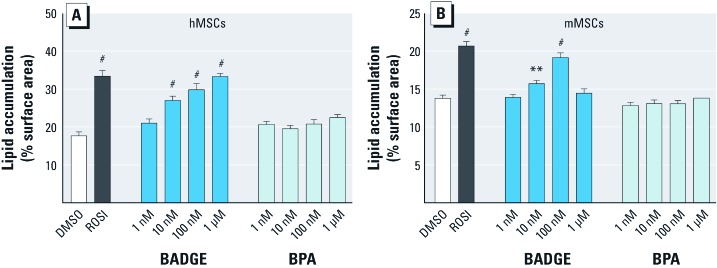
Dose response of MSCs adipogenic capacities to in vitro exposure to BADGE and BPA. Adipogenesis was induced in hMSCs (A) and mMSCs (B) by the addition of an adipogenic cocktail for 14 days in the absence (DMSO) or presence of ROSI 500 nM or increasing doses of BADGE and BPA. All data are expressed as mean ± SE lipid accumulation in six replicates. *p < 0.05, **p < 0.01, and #p < 0.001 relative to vehicle (DMSO) controls.